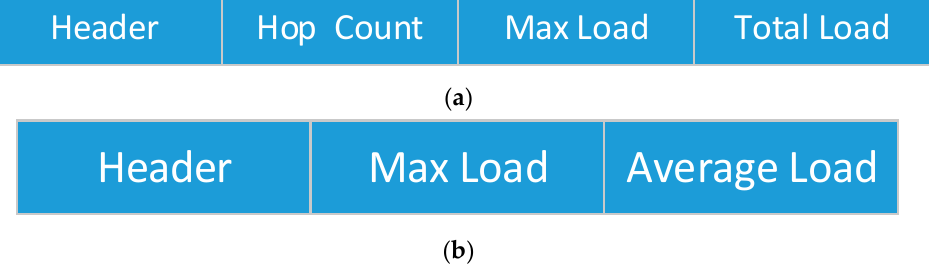
Figure 3. The format of messages. ( a ) The format of the path state detection message; ( b ) the format of the detection response message.